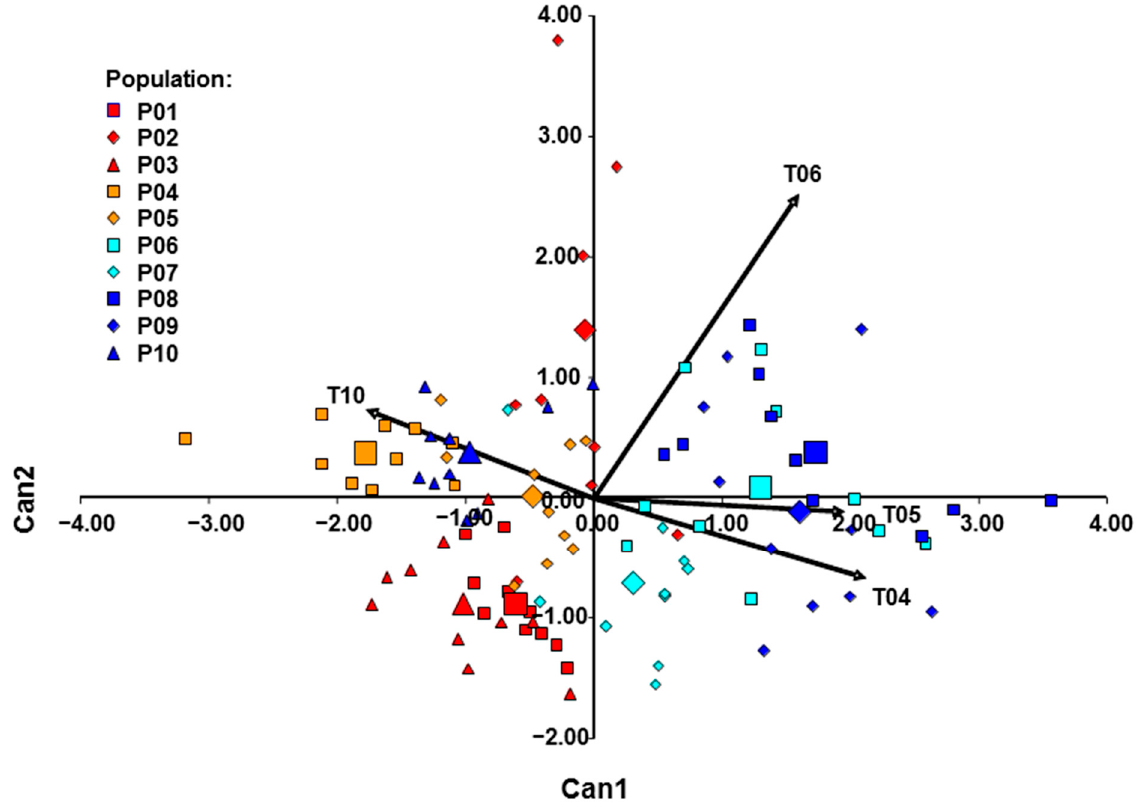
Figure 8. DA of the investigated Micromeria croatica populations from Croatia (Cr1–Cr5), Bosnia and Herzegovina (BH1–BH4), and Montenegro (Mn). LL/LW, length/width ratio of leaves; nF, number of fl owers per shoot; PL, pedicel length; TuL, calyx tube length. The length of the vector is propor- tional to the discriminatory power of the variable.